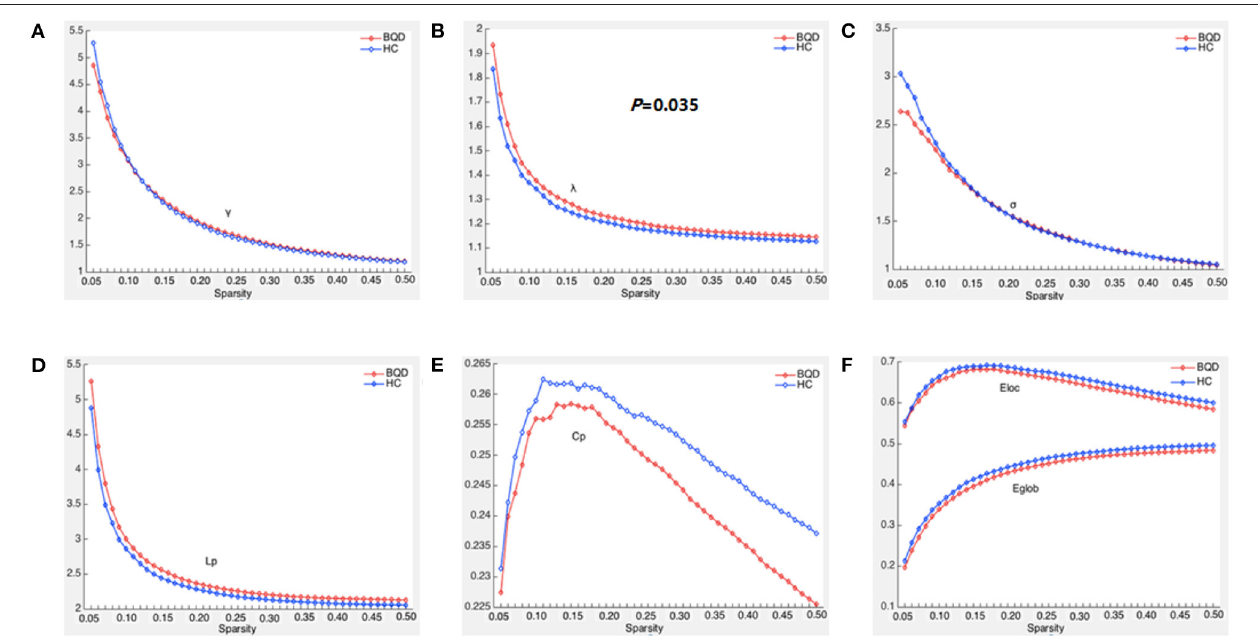
FIGURE 1 | Global parameters of brain functional connectivity network in BQD group and HC group changed with threshold. (A) Within the threshold range, the normalized weighted clustering coefficient ( γ ) decreases with the increase of the threshold and is > 1. (B) Within the threshold range, the normalized weighted characteristic shortest path length ( λ ) decreases with the increase in the threshold and is > 1, and the λ parameter value of the BQD groups was larger than that of the HC groups. (C) Within the threshold range, the small world property ( σ ) decreases with the increase in the threshold and is > 1. (D) Within the threshold range, weighted characteristic shortest path length (Lp) decreases with the increase in the threshold, and the Lp parameter value of the BQD groups was larger than that of the HC groups. (E) Within the threshold range, the weighted clustering coefficient (Cp) parameter value of the BQD groups was lower than that of the HC groups. (F) Within the threshold range, the global efficiency (Eglob) and local efficiency (Eloc) parameter value of the BQD group was lower than that of the HC group.